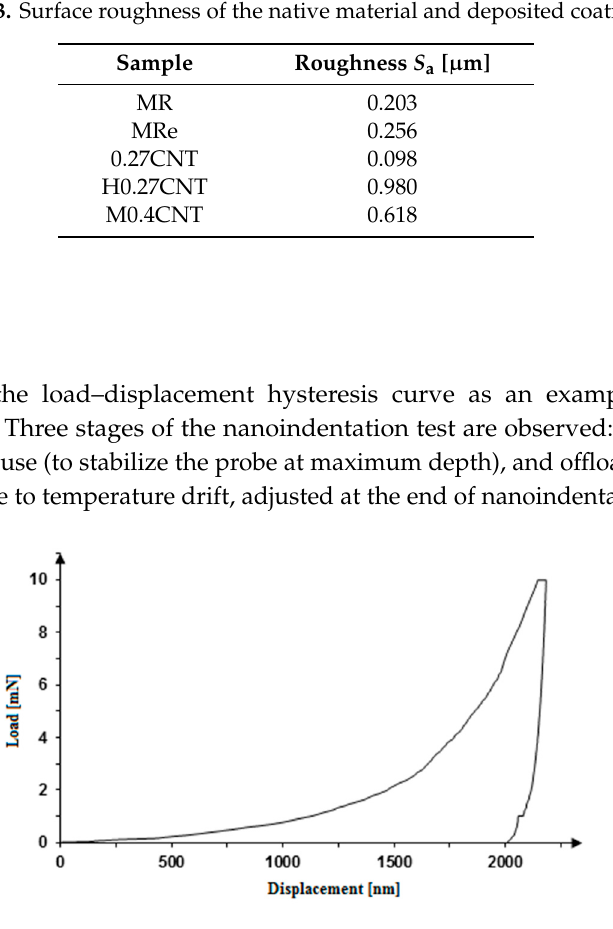
Figure 3. Nanoindentation load–displacement curve obtained for pure CNT coating (0.27CNT).